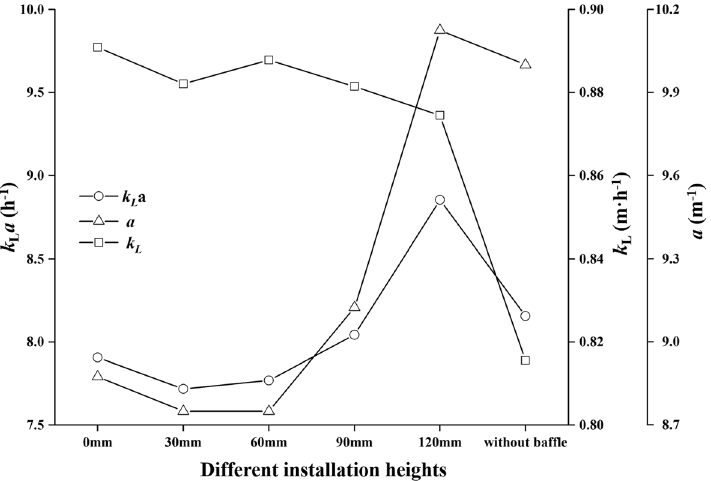
Figure 7. The effect of different installation heights on k L a , A and k L a in the OSRs at filling volume of 8 L and shaking speed of 100 rpm. The values of k L and a were calculated in the hollow OSRs with different installation heights as indicated, separately. The value of k L a was determined based on the result of k L and a . The circle ( represents the value of k L a , the triangle ( ) represents the value of a , and the square ( (cid:31) ) denotes the value of k L △